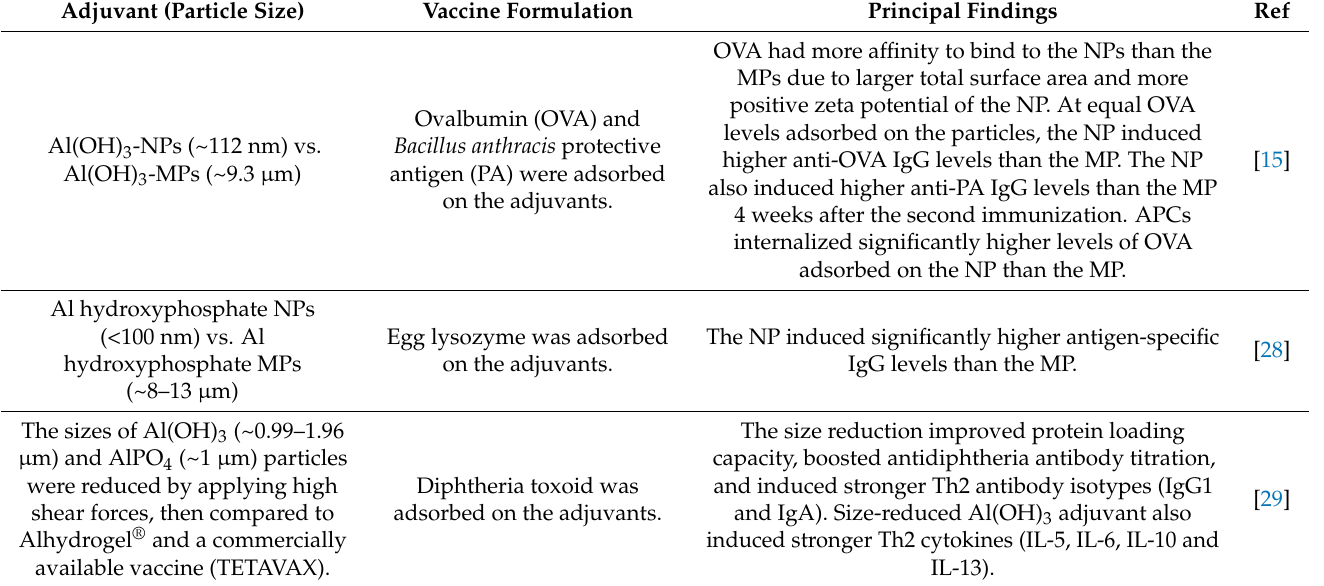
Table 1. Adjuvanticity of Al-NPs compared to microadjuvants and vaccines. Adjuvant (Particle Size) Vaccine Formulation Principal